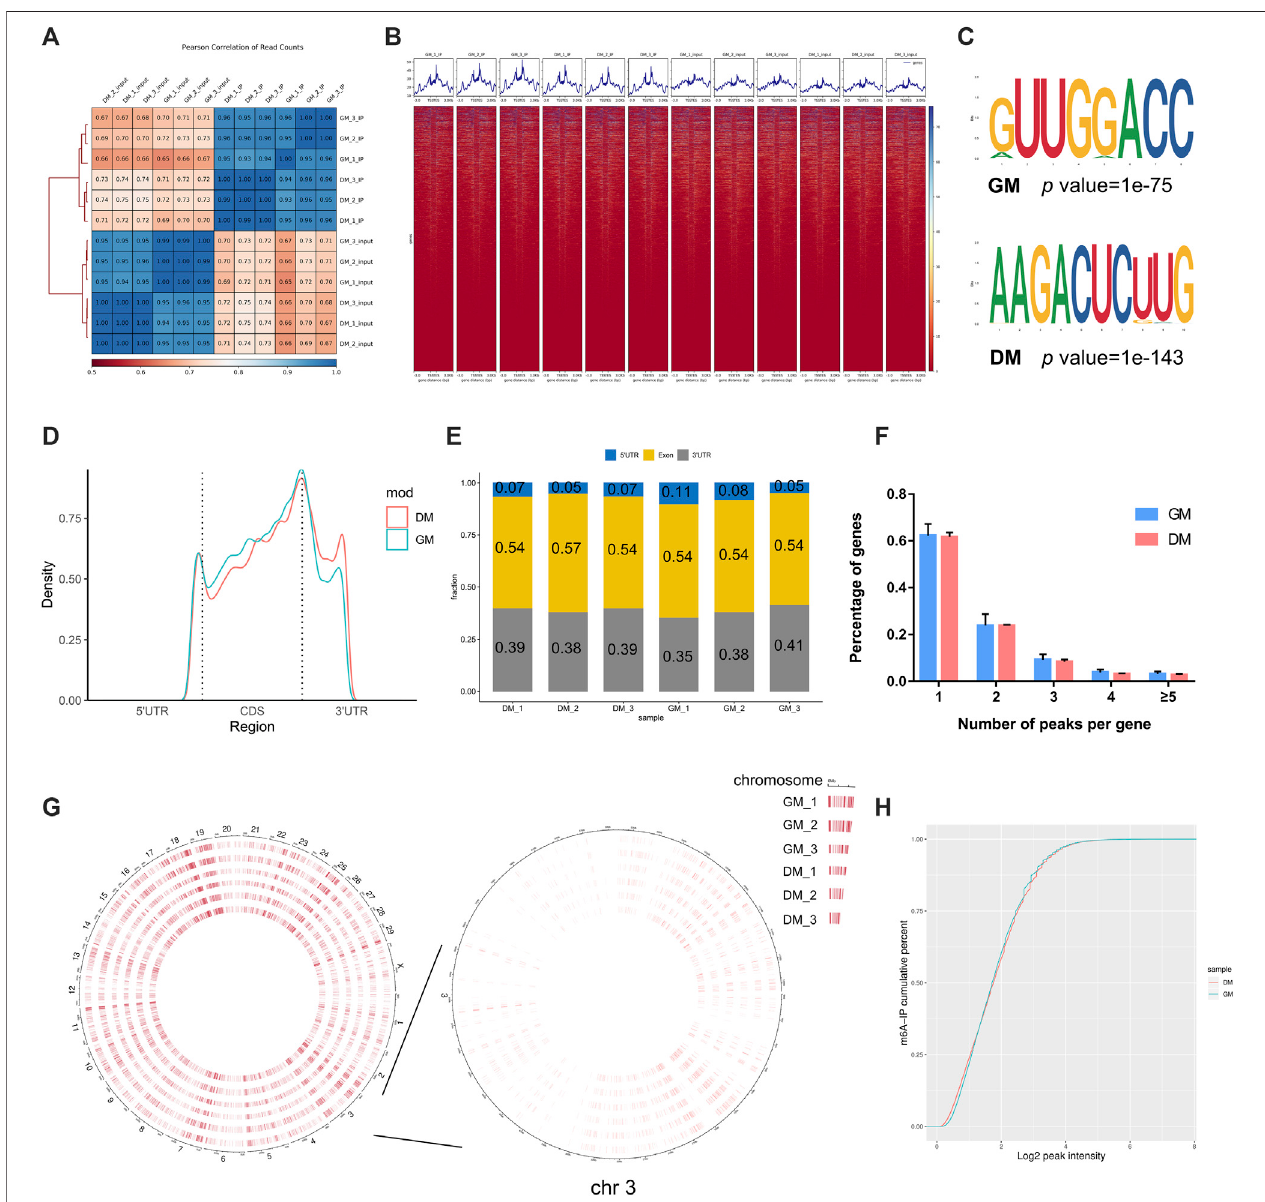
FIGURE 2 | Overview of samples and m 6 A methylation of mRNAs in bovine skeletal myoblasts and myotubes. (A) Pearson correlation analysis showing the correlation between the groups, represented as values in modules. (B) Distribution of peaks on gene functional elements in all groups. (C) Sequence motifs identi fi ed withinm 6 Apeaks. (D) Metagenepro fi lesofm 6 Apeaksdistributionacrossthe5 ′ UTR,CDS,and3 ′ UTRinGMandDM. (E) Percentageofm 6 Apeakin5 ′ UTR,CDS,and 3 ′ UTR of mRNA. (F) Percentage of m 6 A-methylated genes with different number of m 6 A peaks. (G) Circos plot showing the global distribution of m 6 A, in cow genome (left) and chromosome 3 (right) of GM and DM. (H) Cumulative curves of m 6 A abundance in GM and DM.